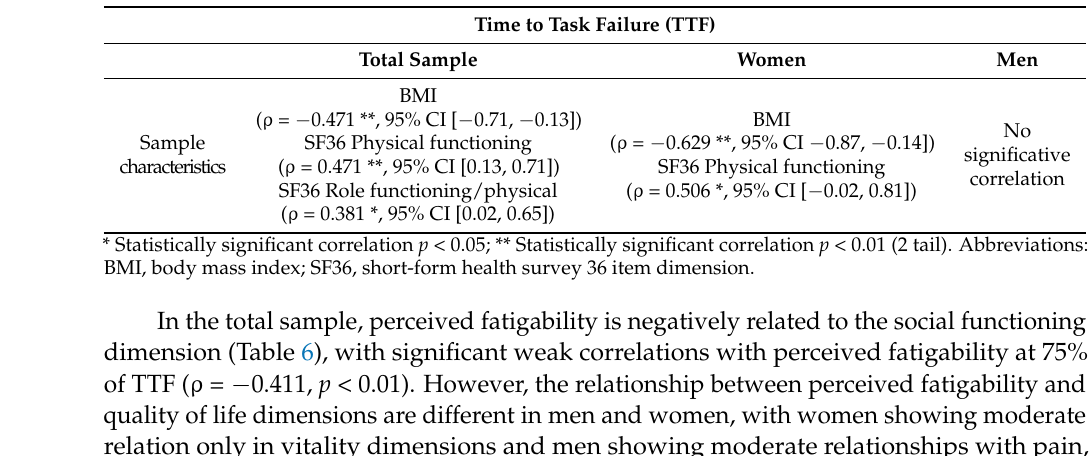
Table 7. Correlation between performance fatigability variables and sample